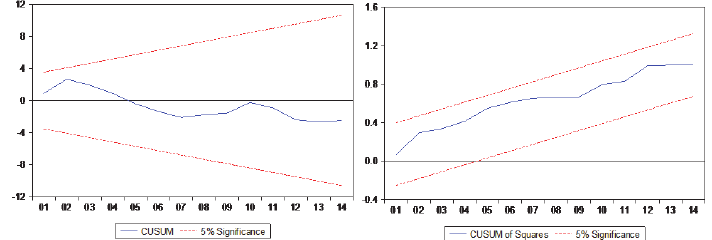
Fig. 1. Results of Cumulative Sum of Recursive Residuals and Cumulative Sum of Square of Recursive